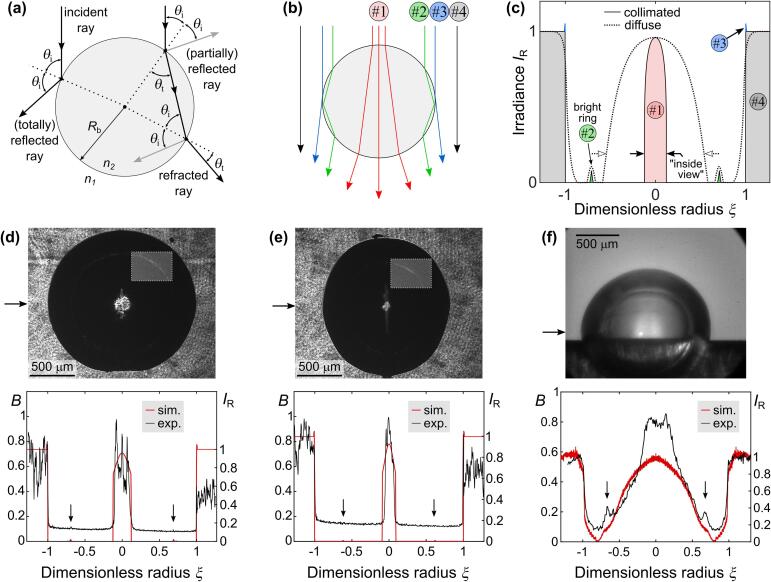
(a) Reflection and refraction of rays at the bubble wall. Angles of incidence and refraction are denoted by θi and θt, respectively. (b) Different types of illuminating rays in a vapor bubble with (c) schematically shown corresponding contribution to irradiance profile. (d)–(f) Images of laser-induced cavitation bubbles acquired by experimental setup #2 in (d) water (n = 1.33) and (e) PEG (n = 1.465) and by (f) experimental setup #1 in water. The arrows on the left-hand side of the acquired images mark the position of the (experimental) irradiance profile in the corresponding bottom graphs, which compare simulation results with experiments. Image brightness B is relevant to experimental profiles, while irradiance IR is relevant to simulated profiles.